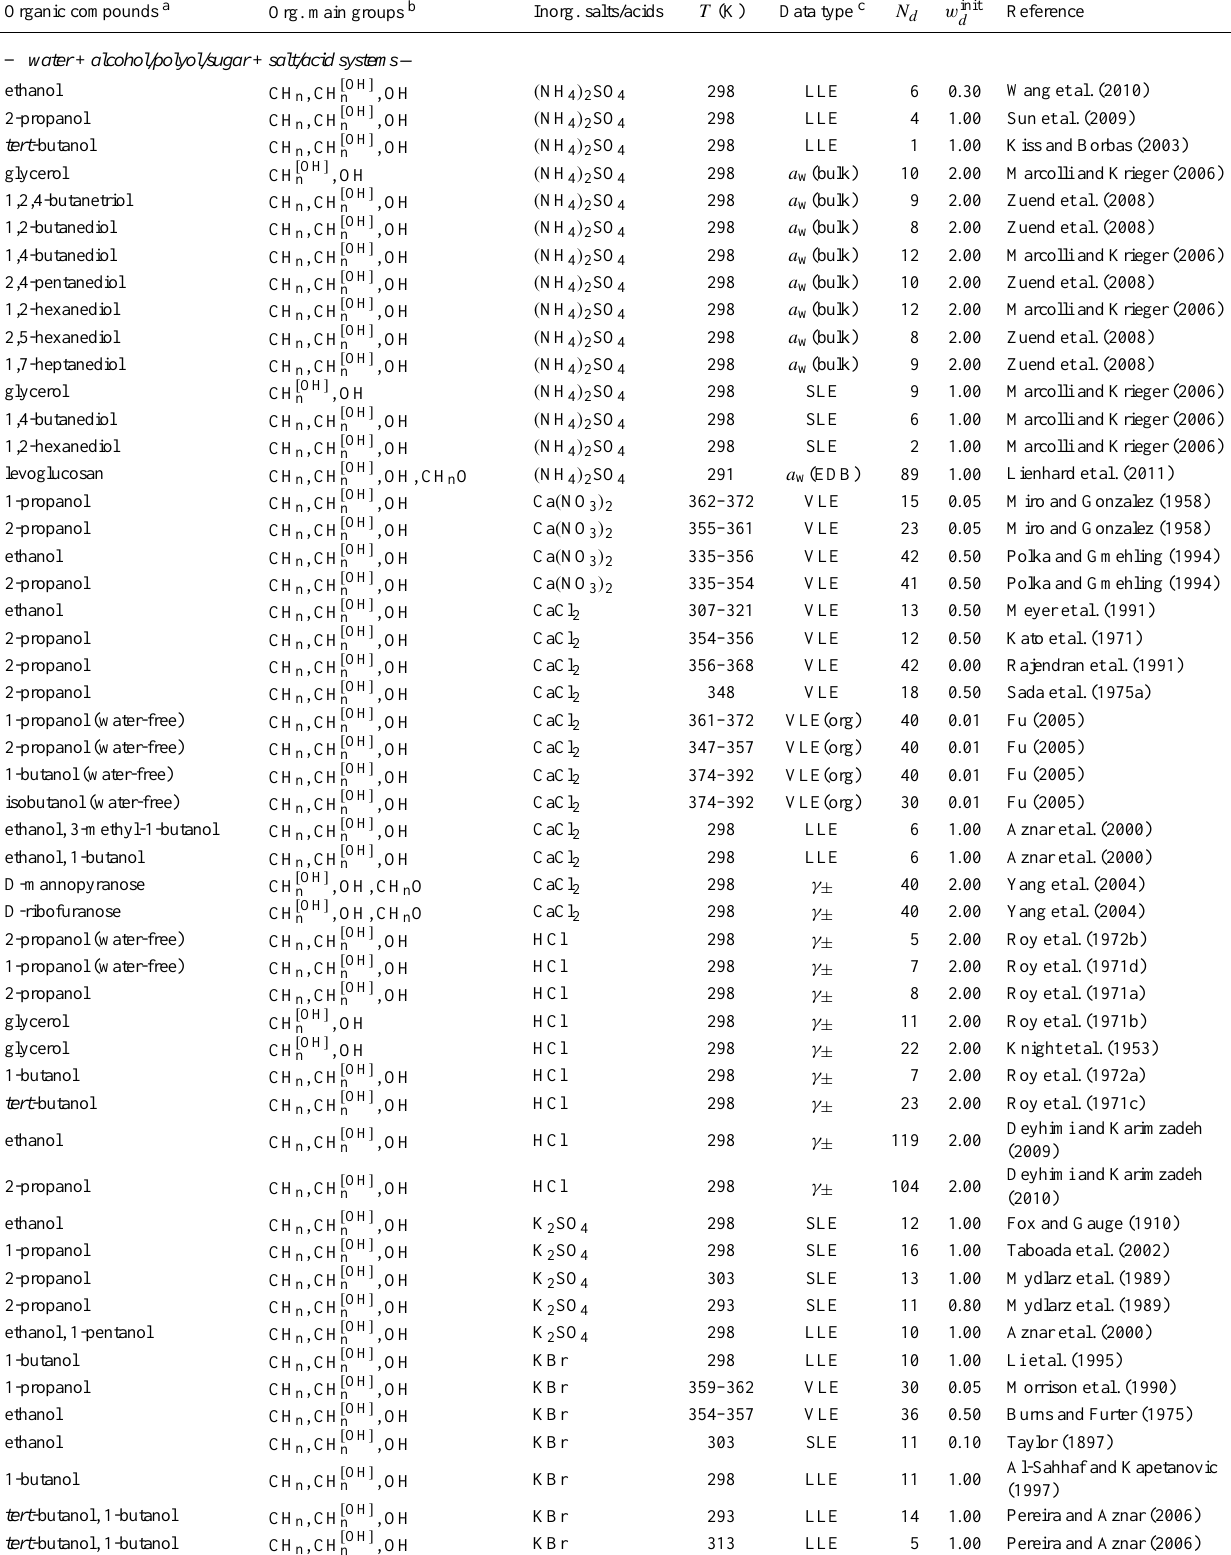
Organic compounds